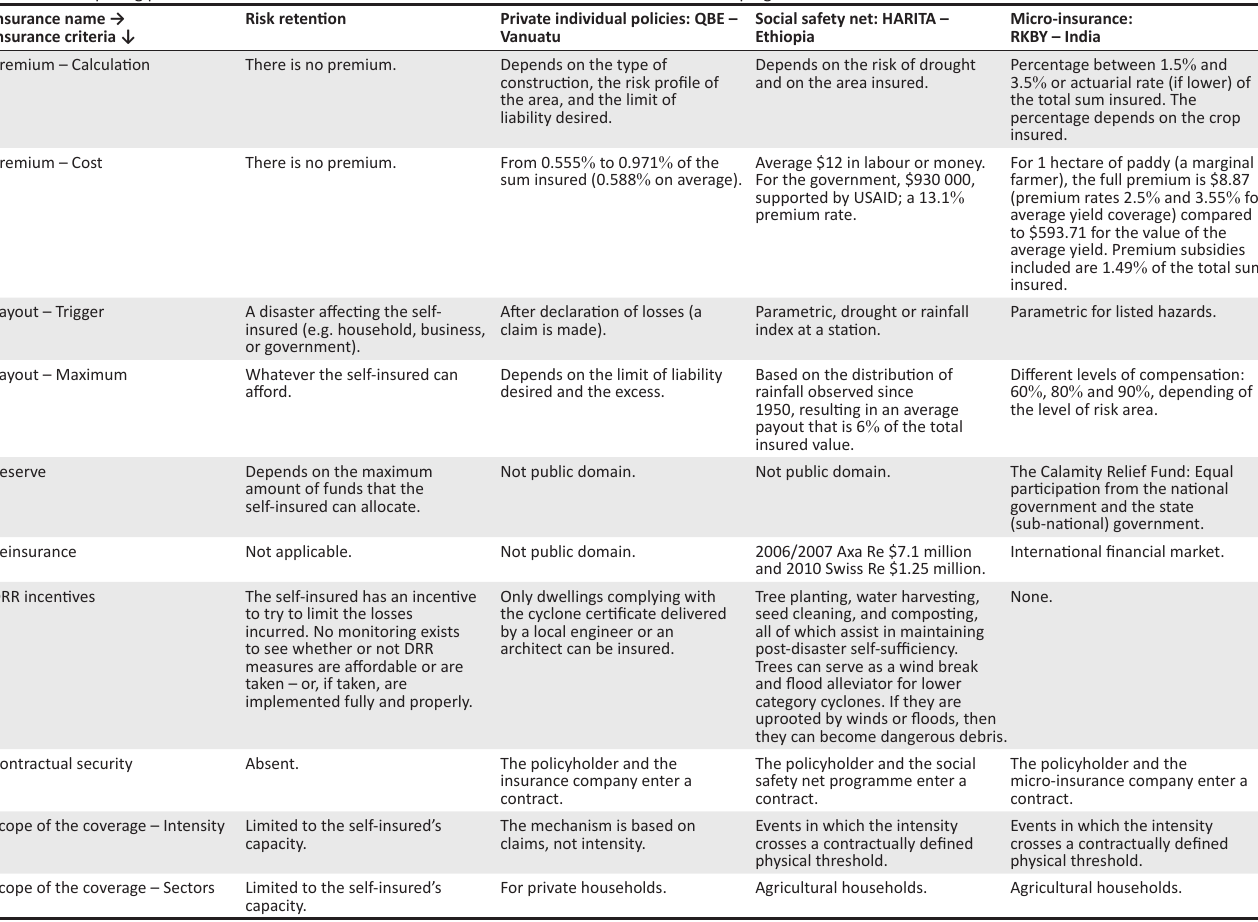
TABLE 2: Comparing private insurance mechanisms to be considered for Pacific Small Island Developing States. Insurance name → Insurance criteria